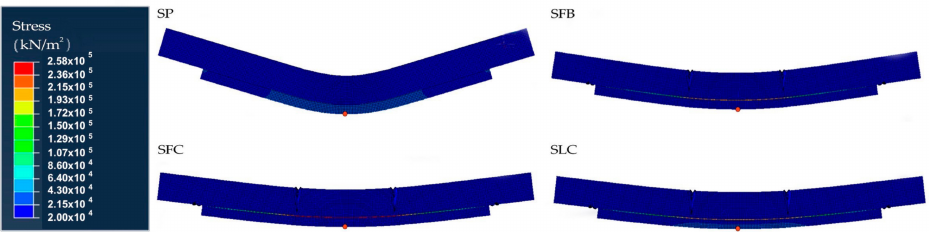
Figure 3. Numerical stress distribution for each specimen.